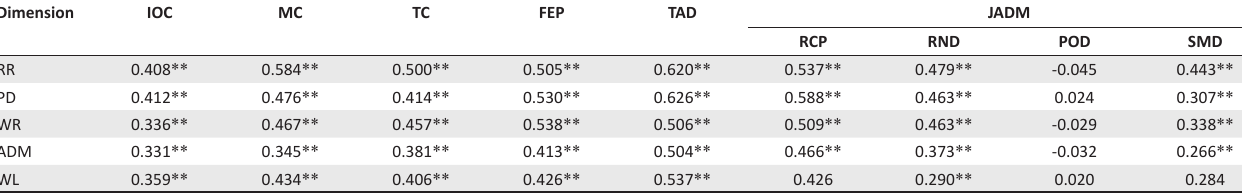
TABLE 6: Correlations between employment equity and employee morale dimensions.